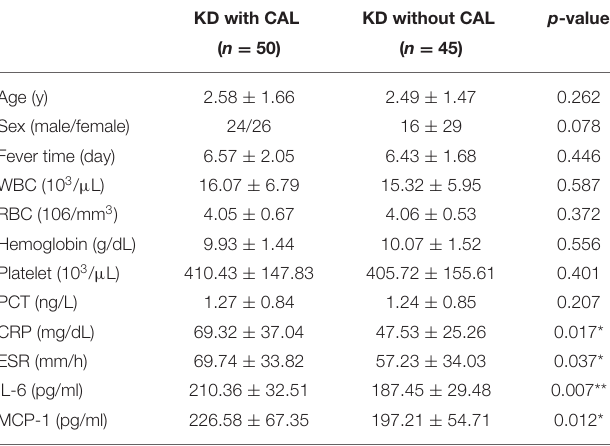
TABLE 2 | Clinical parameters in two groups of KD